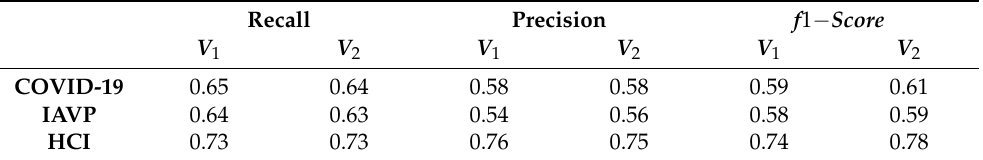
Table 2. Model performance evaluation metrics on recall, precision, and f1-score of both classification models for COVID-19, IAVP, and a Healthy Candidate without infection (HCI).